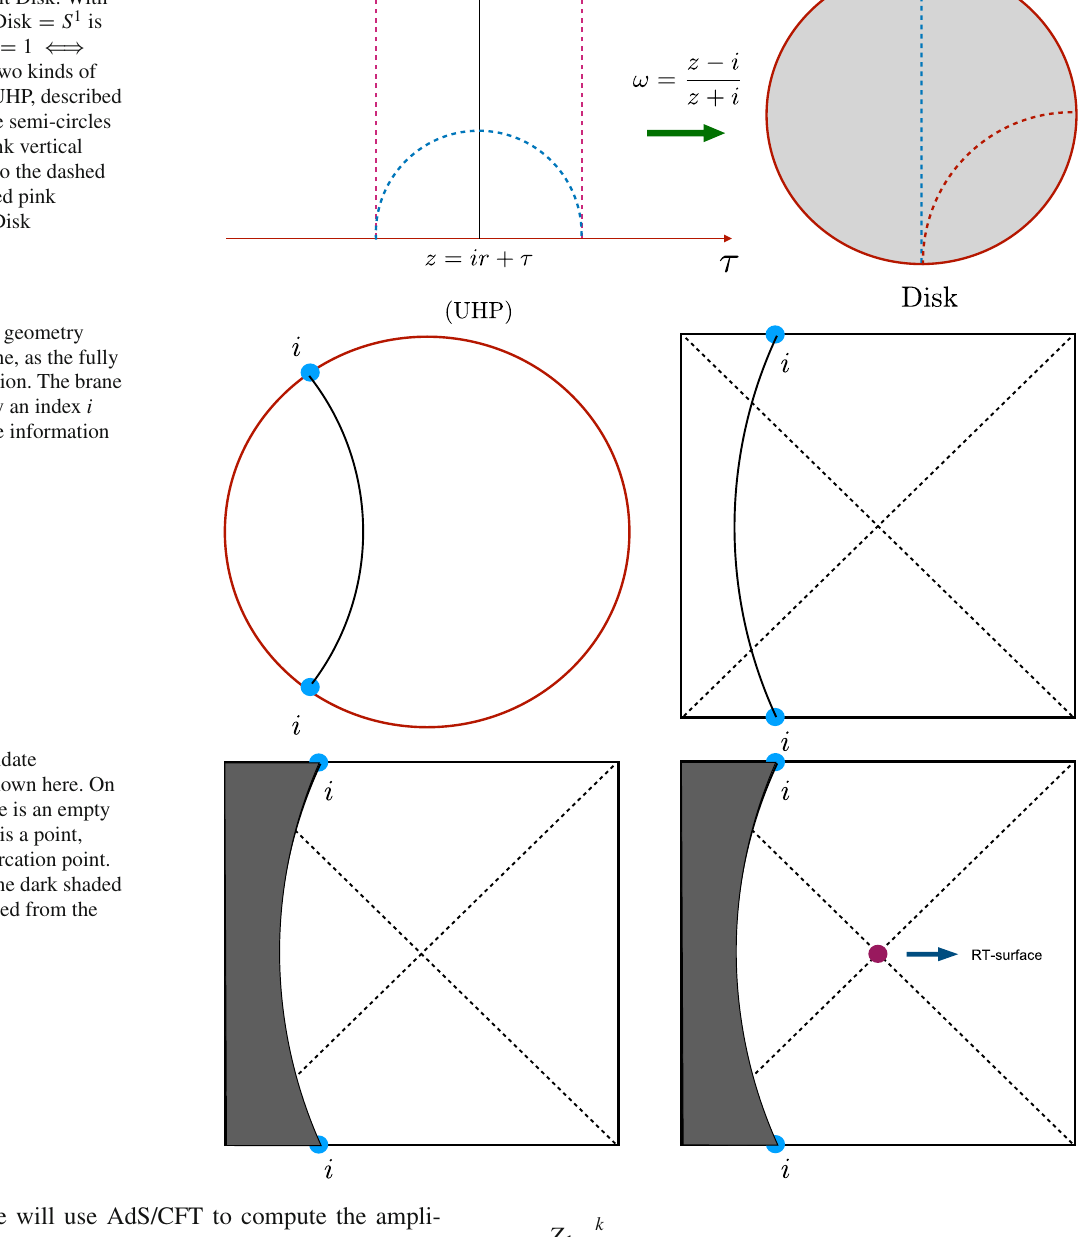
Fig. 6 The AdS 2 geometry with an EOW-brane, as the fully back-reacted solution. The brane is characterized by an index i which captures the information of the microstates